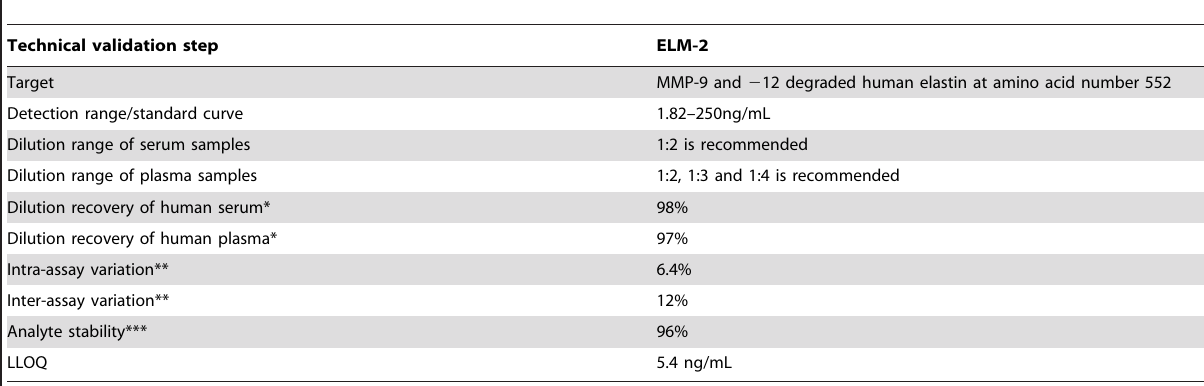
Table 1. Summary table of the technical validation of the ELM-2